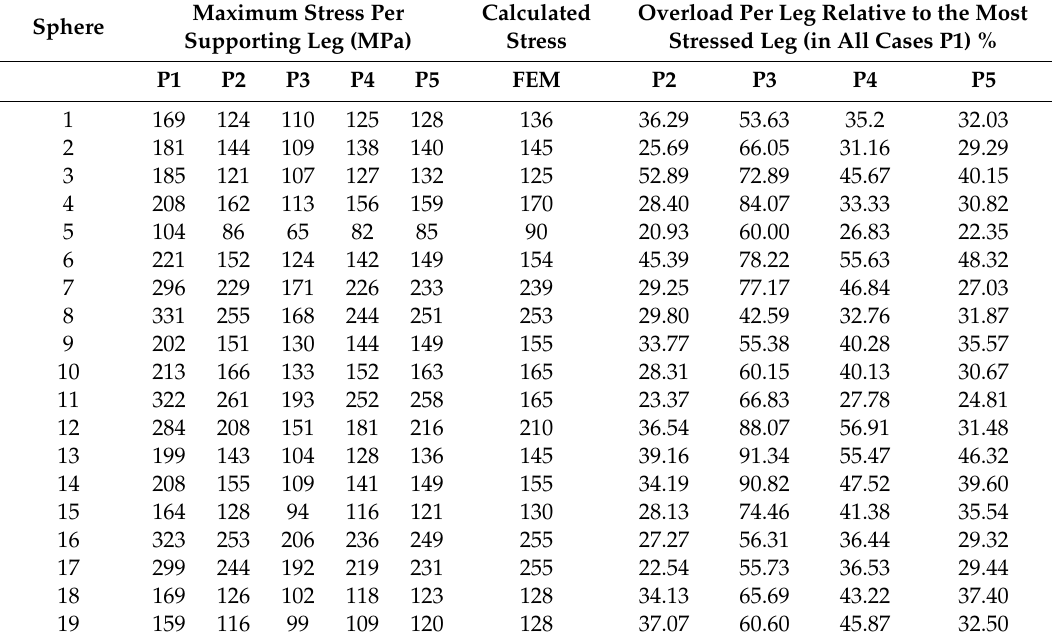
Table 3. Determined values for the most strained / stressed